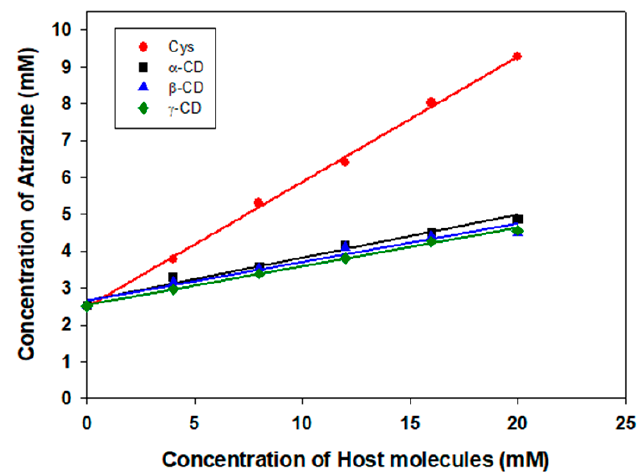
Figure 2. Phase solubility diagrams of atrazine in aqueous solution with Cys, α -CD, β -CD, and γ -CD at 25 °C. Polymers 2019 , 11 , x FOR PEER REVIEW